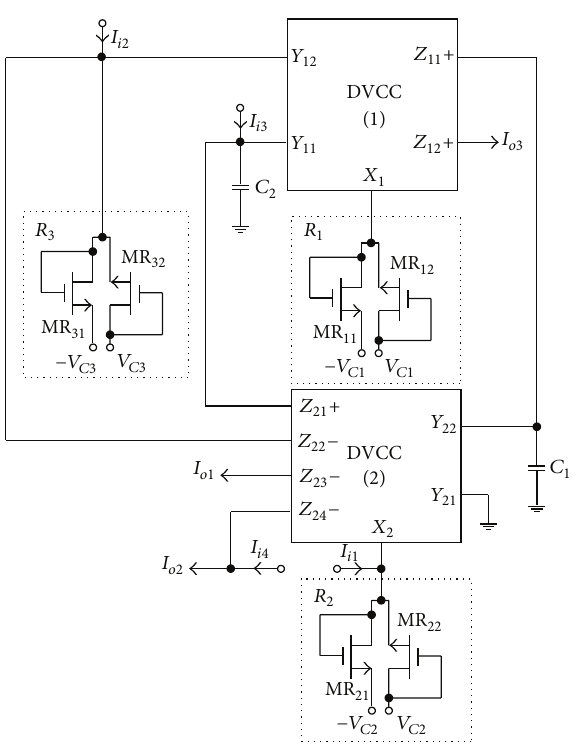
Figure 1: Proposed electronically tunable current-mode universal biquadratic